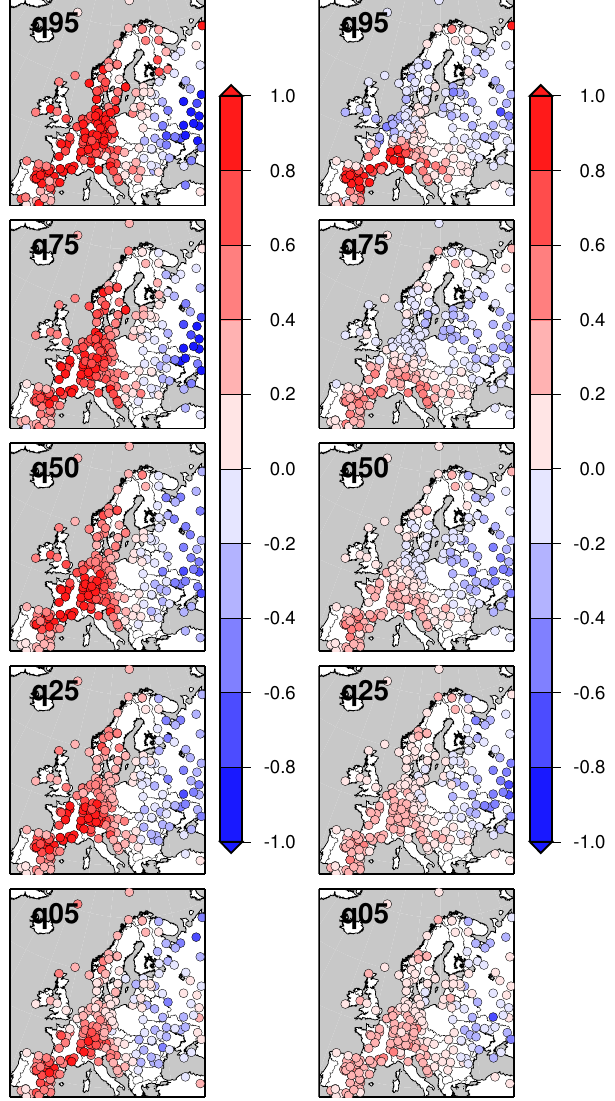
Fig. 5. Left column: differences of quantiles between observed and simulated temperature anomalies with “static” weather generator initiated on 21 June 2003 (in ◦ C). Right column: differences of quantiles between observed and simulated temperature anomalies with “dynamic” weather generator with a 21 June 2003 initialisa-